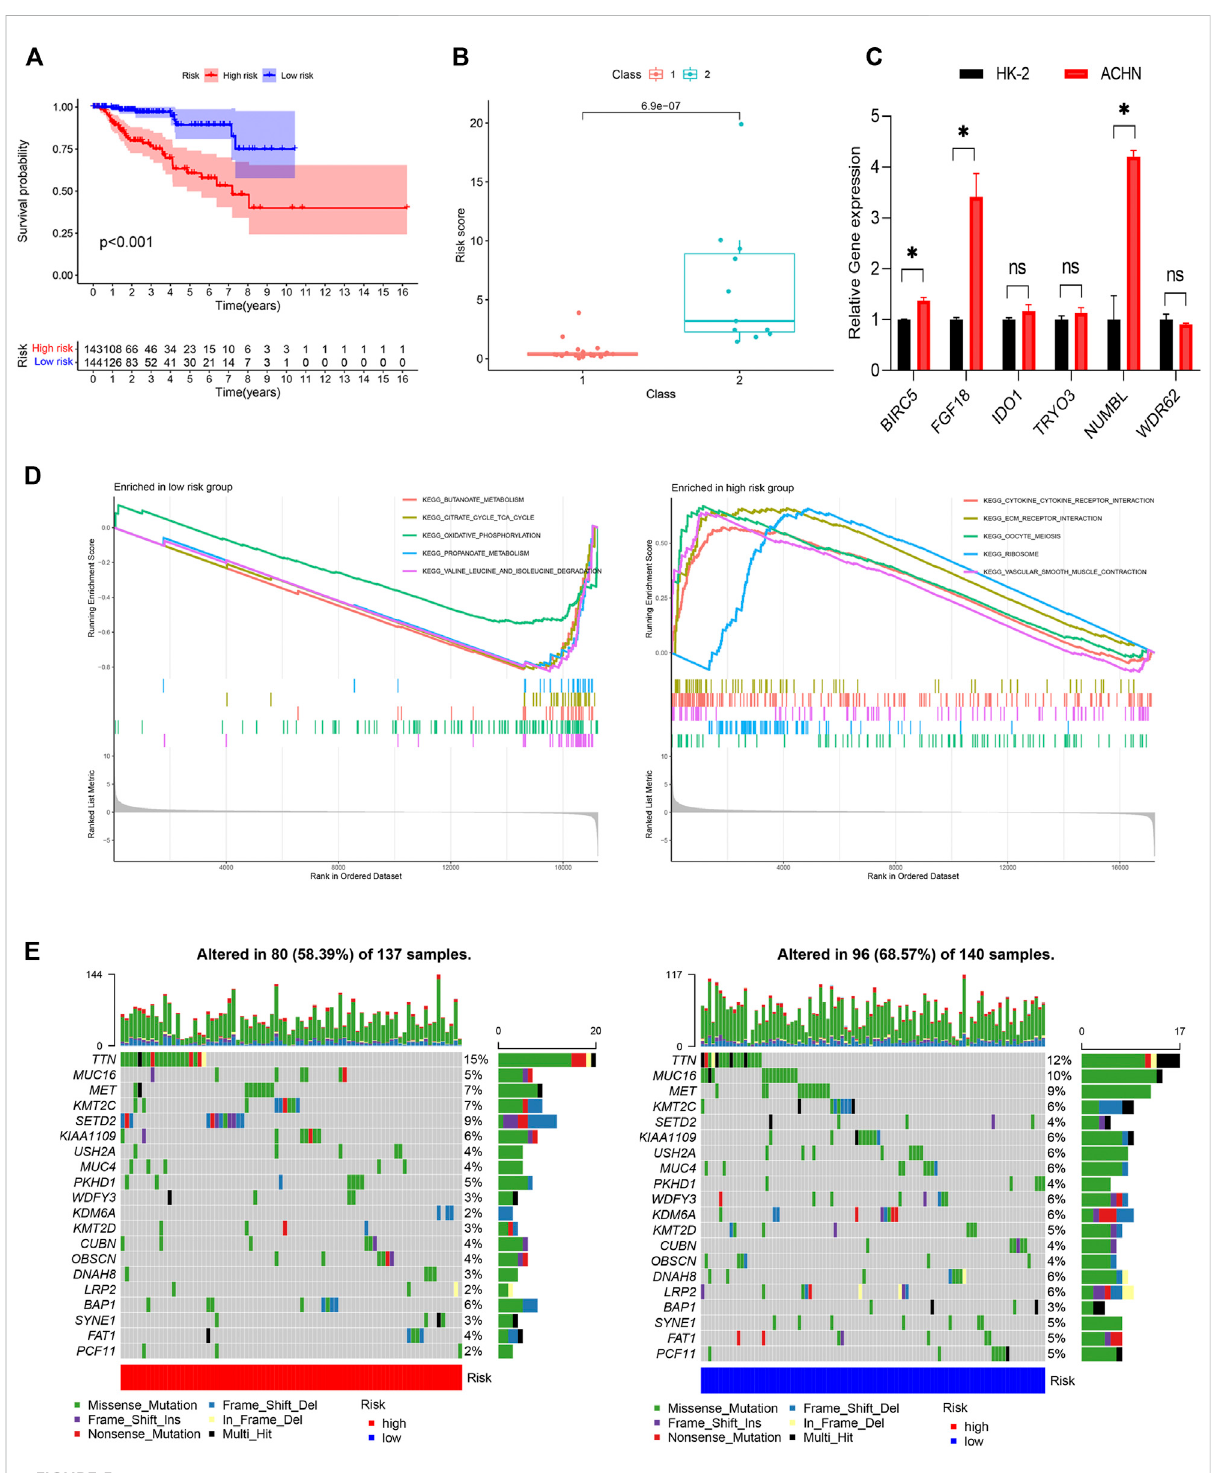
FIGURE 5 ConstructionoftheIRGPI. (A) TheK-MsurvivalanalysisoftheIRGPI. (B) TherelationshipsbetweenIRGPIandpathologicalclassi fi cationinPRCC cohort from GEO database. (C) The gene expression levels in the IRGPI were evaluated by real-time qPCR. * p < 0.05; ns, non signi fi cance. (D) Different gene sets enriched in the IRGPI subgroups. (E) Differences in the mutational status within the IRGPI subgroups. IRGPI, immune-related gene prognostic